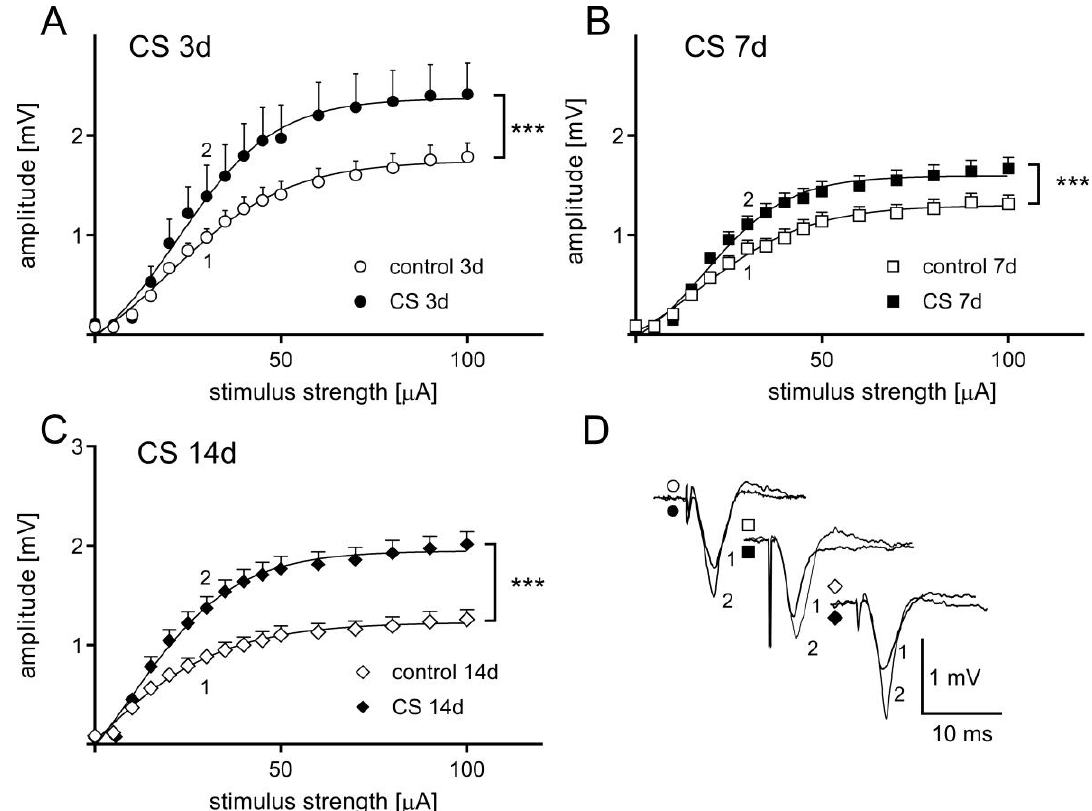
Figure 3. The influence of crowding stress on basal synaptic transmission in the frontal cortex (FC) of rats. The relationship between the stimulus strength and the field potential (FP) amplitude recorded in FC slices from ( A ) control ( n = 11) and CS 3d ( n = 8), ( B ) control ( n = 19) and CS 7d ( n = 19), ( C ) control ( n = 19) and CS 14d ( n = 18). FP traces in ( D ) show a superposition of averaged FPs recorded in representative experiments at the points indicated by numbers. Symbols (circles, squares, and diamonds) correspond to appropriate plots (A–C). Data are presented as means ± SEM and fitted with Boltzmann functions, whereas statistical comparisons are made for the maximum parameter taken from the Boltzmann fit. *** p < 0.0001 vs. control (post-hoc Sidak’s test).